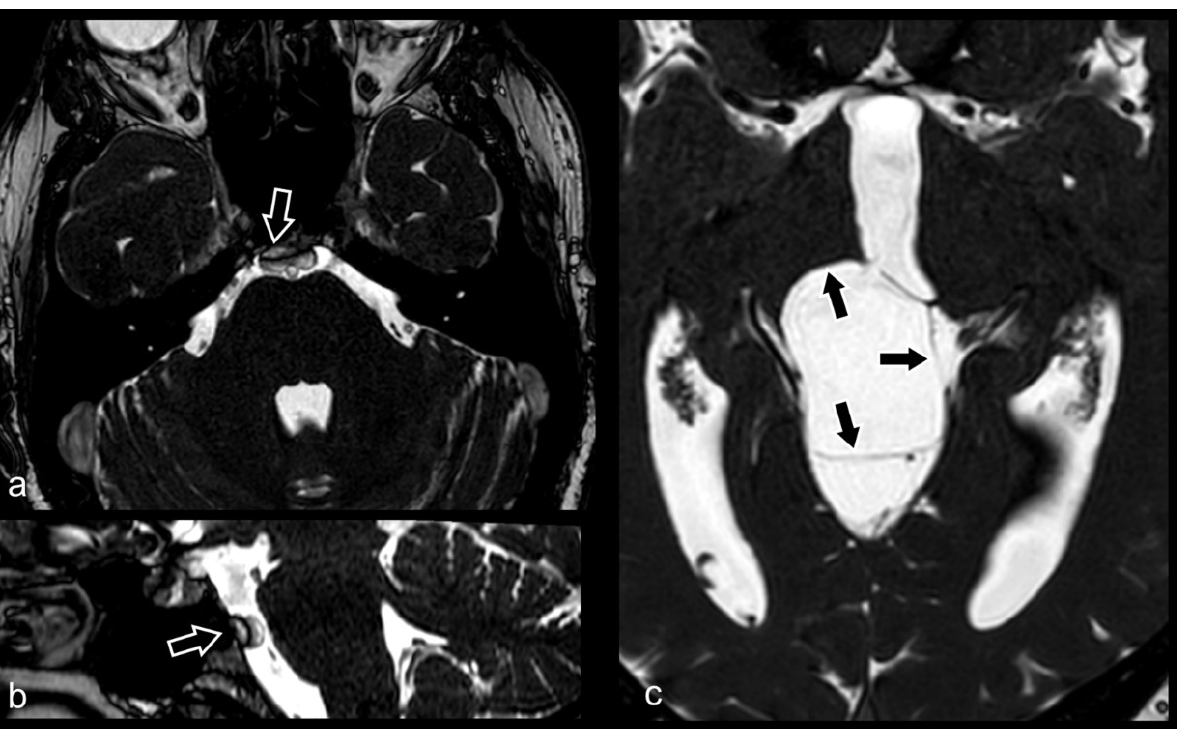
Figure 8. ( a , b ) Focal extra-axial CSF-like lesion (arrow) located in the prepontine cistern. The lesion is strictly adherent to, and partially extends into, the clivus, and abuts the basilar artery, without signs of mass effect. Location and signal characteristics are in keeping with ecchordosis physaliphora. ( c ) Axial 3D CISS image shows a quadrigeminal cistern arachnoid cyst (cyst walls indicated by arrows) causing supratentorial hydrocephalus.